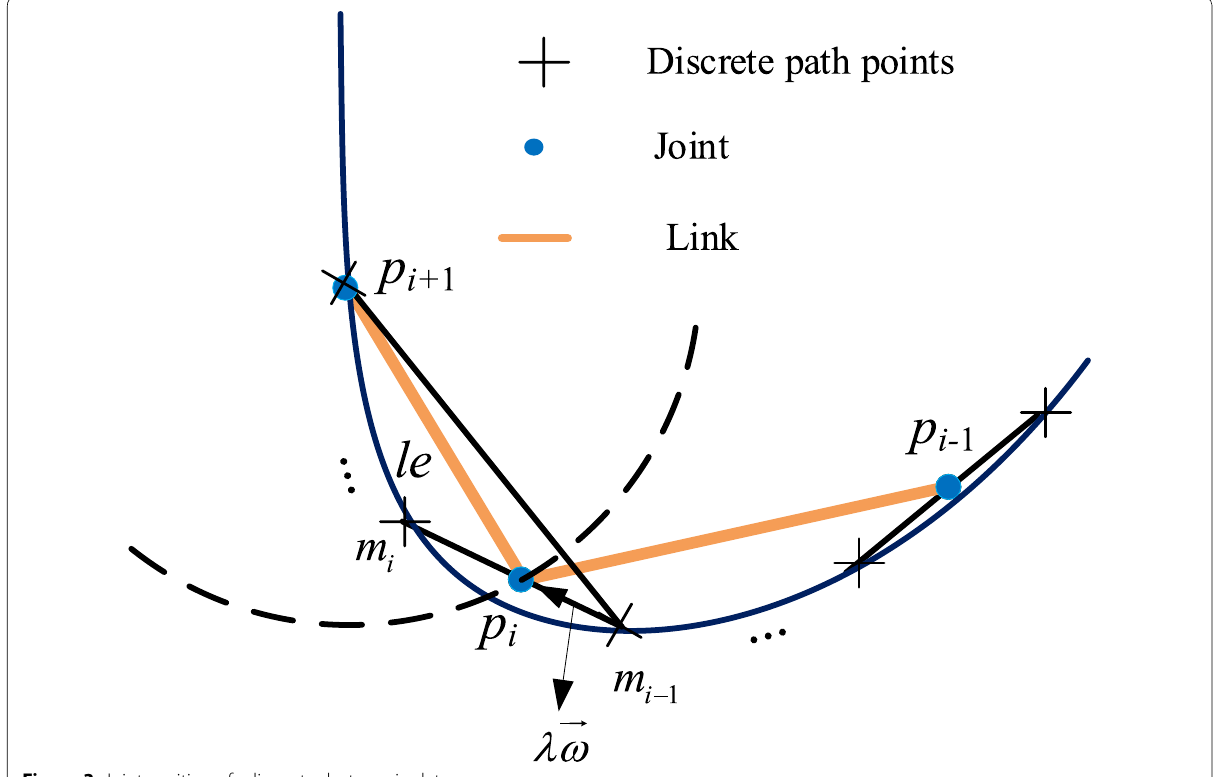
Figure 3 Joint position of adjacent robot